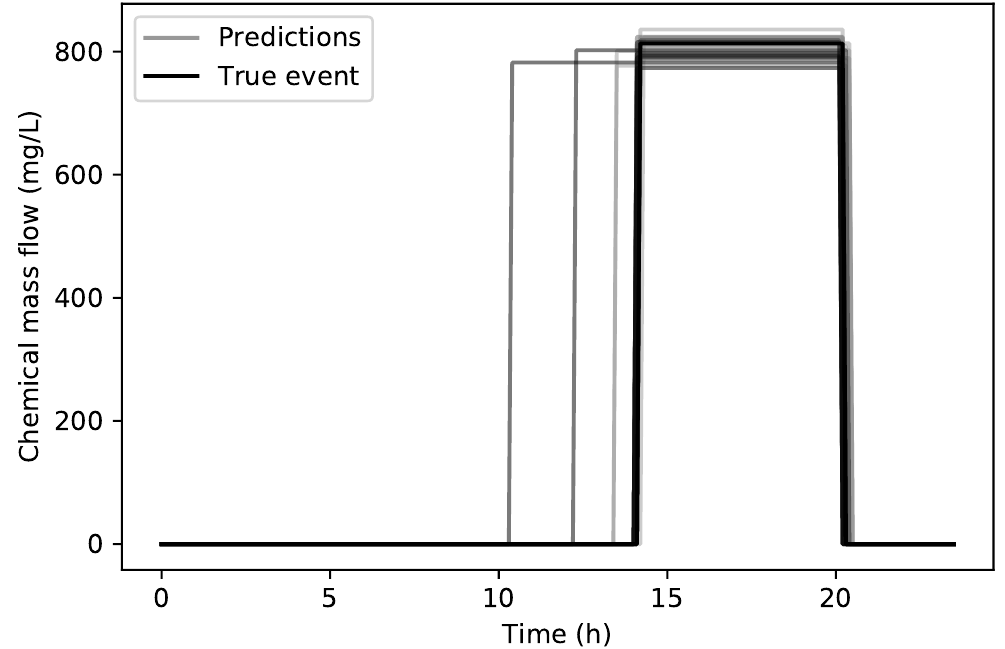
Figure 7. Net3 network true contamination event (black) and predicted contamination events (grey).